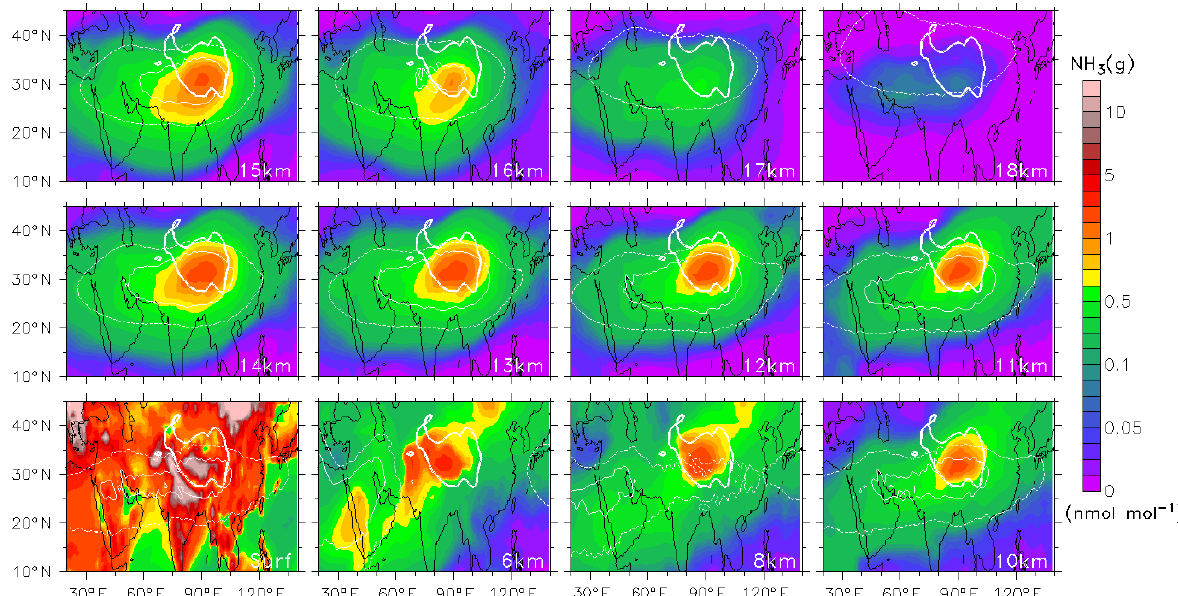
Figure 14. EMAC-simulated ammonia in the gas phase, NH 3 (g), in units of nanomole of ammonia per mol of air (nmolmol − 1 ) or parts of ammonia per billion of air in volume (ppbv), at selected altitudes, i.e., at the surface and 6, 8, 10, 11, 12, 13, 14, 15, 16, 17, and 18kma.s.l., averaged for July–August 2012. Thin white lines refer to the contour of pressure deviation, as defined in Fig. 2, and thick white lines highlight the Tibetan Plateau